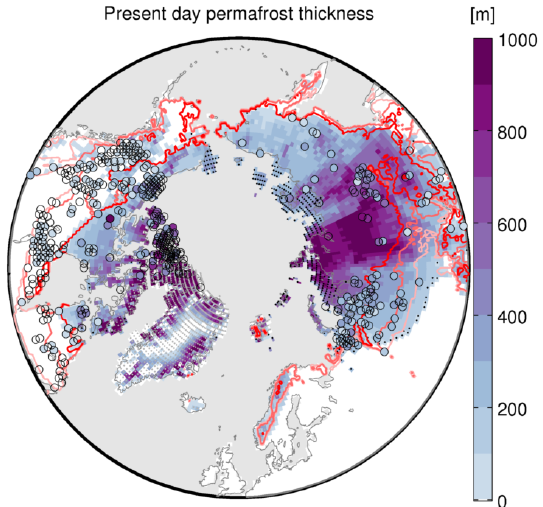
Figure 6. Scatter of modeled and observed permafrost thickness estimated from boreholes. Permafrost thickness data for Canada (blue) are from Smith and Burgess (2004) and for Siberia (red) from Melnikov (1998). Filled circles represent modeled permafrost thickness using the Pollack et al. (1993) and open circles using the Davies (2013) geothermal heat